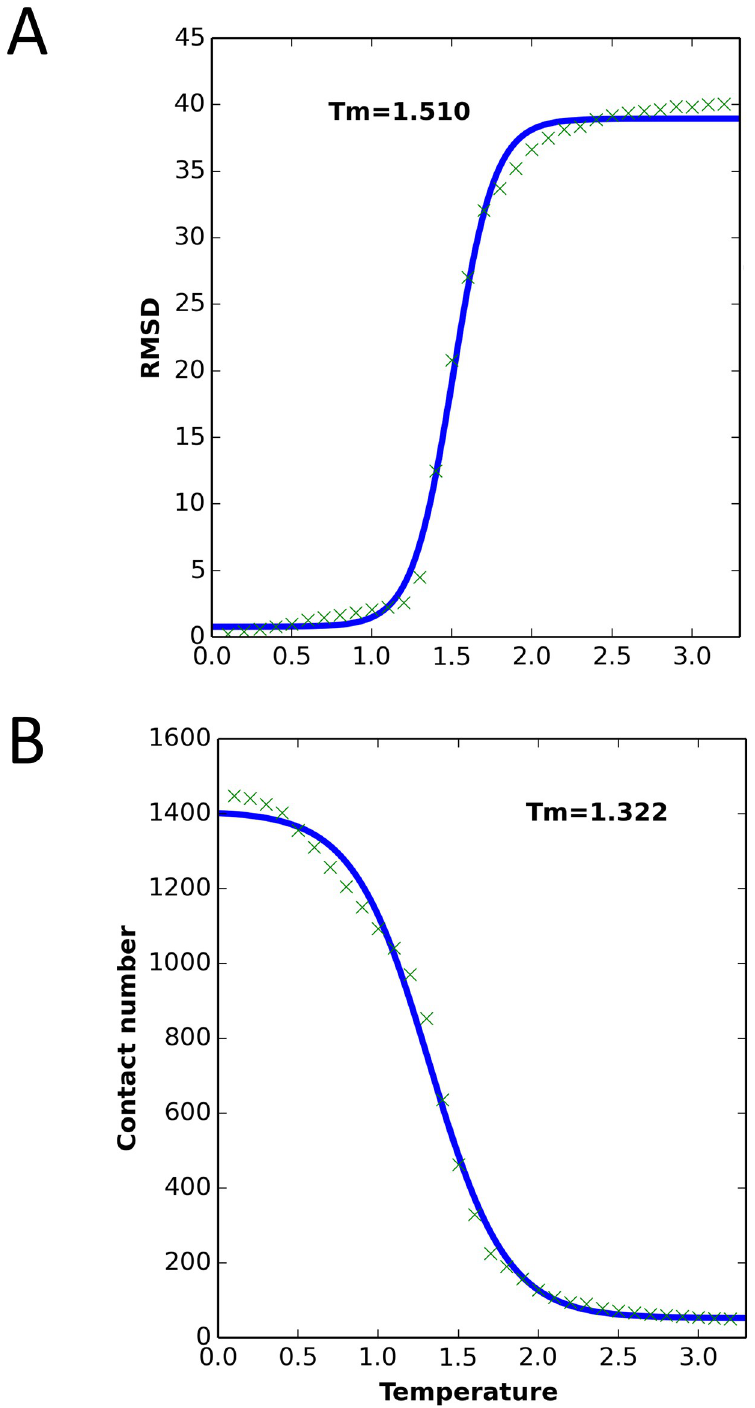
Fig 3. WT DHFR unfolding curves from MC simulations, averaged over 2,000,000 simulation steps, with 50 replications. The T m value was calculated based on the sigmoidal fit (solid blue line). (A) RMSD vs. simulation temperature. (B) Number of contacts vs. simulation temperature.